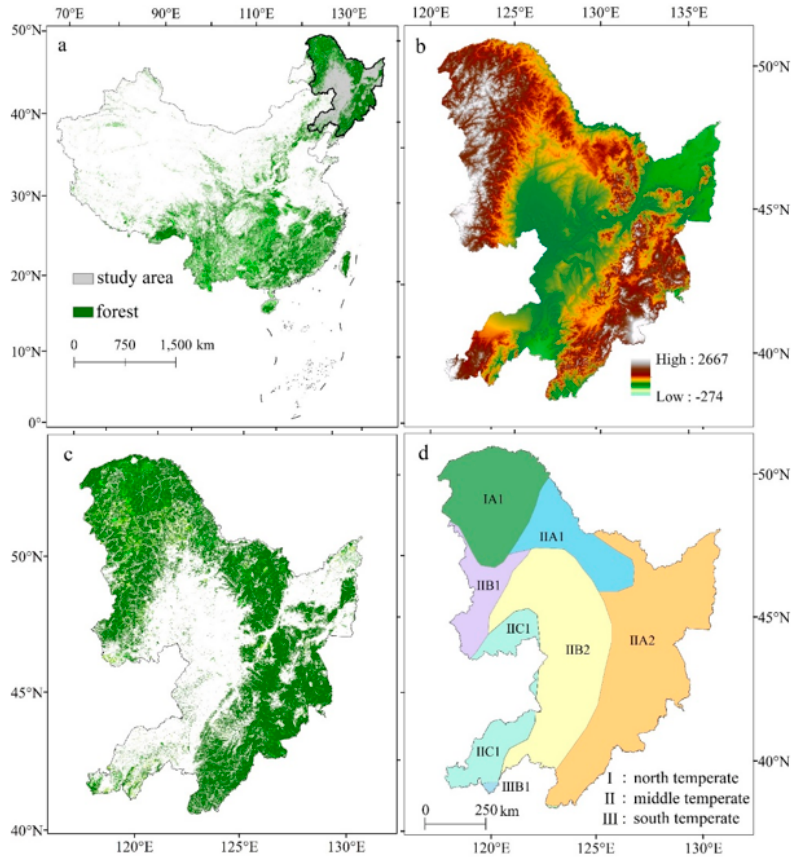
Figure 1. Main overview of the NCF ( a – d ) represents district, DEM, forest distribution, and climate zone, respectively.